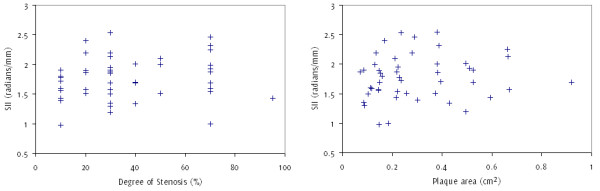
Scatter plot of the plaque surface irregularity index
versus
the degree of stenosis of the corresponding artery (left) and the plaque area (right), illustrating a lack of association between these parameters.